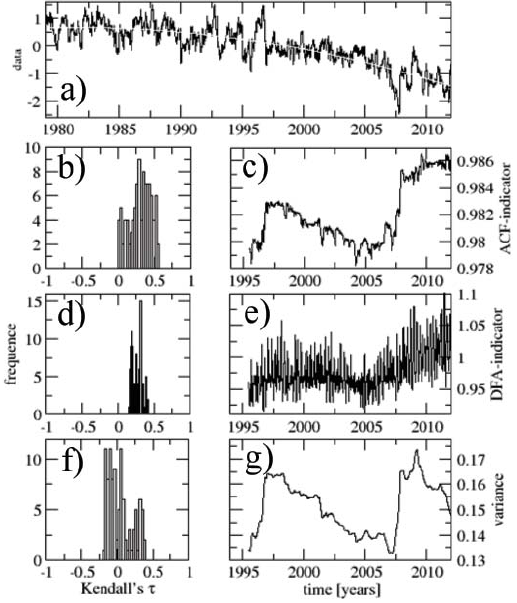
Fig. 8. Search for early warning signals of bifurcation in summer–autumn Arctic sea-ice area. (a) Summer–autumn sea-ice area anomaly (as in Fig. 7a) showing the quadratic downward trend that is removed prior to calculating the instability indicators. Right panels show example indicators from (c) autocorrelation function (ACF), (e) detrended fluctuation analysis (DFA) and (g) variance, results plotted at end of a sliding window of length half the series. Left panels show histograms of the Kendall statistic for the trend in the indicators when varying the sliding window length from 1/4 to 3/4 of the series: (b) ACF-indicator; (d) DFA-indicator; (f) variance.